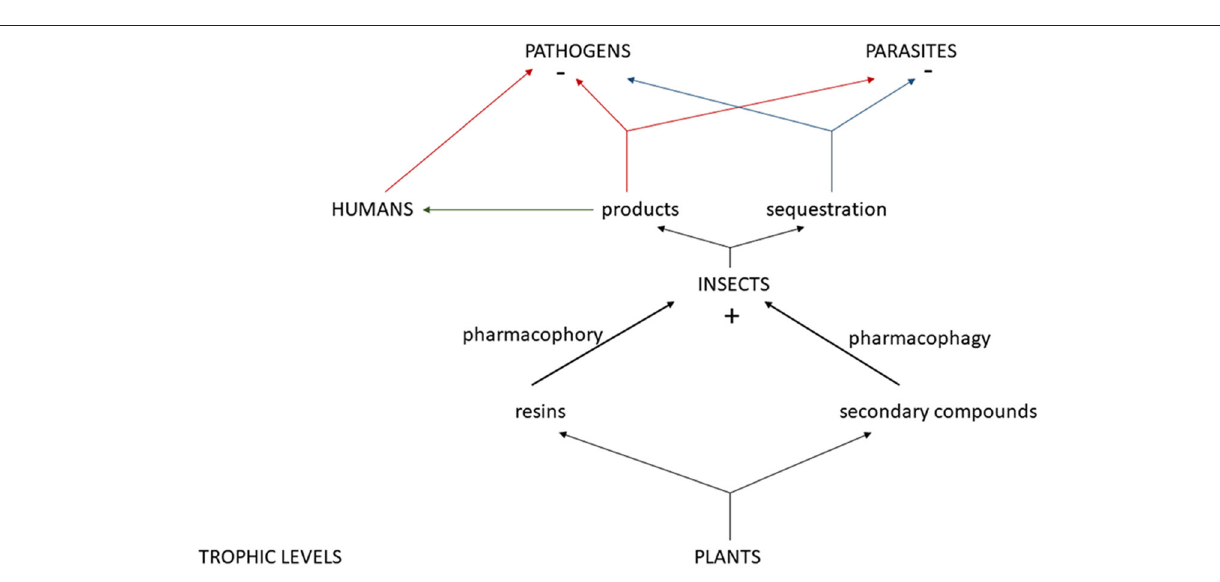
FIGURE 3 | Mulitrophic interactions between plants and their resins and secondary compounds, insects, and their positive impact ( + ) from sequestered secondary compounds and/or products from pharmacophory and pharmacophagy, the negative (–) impact of these products and/or sequestered plant compounds on pathogens and parasites, and how humans can use these products for pathogen